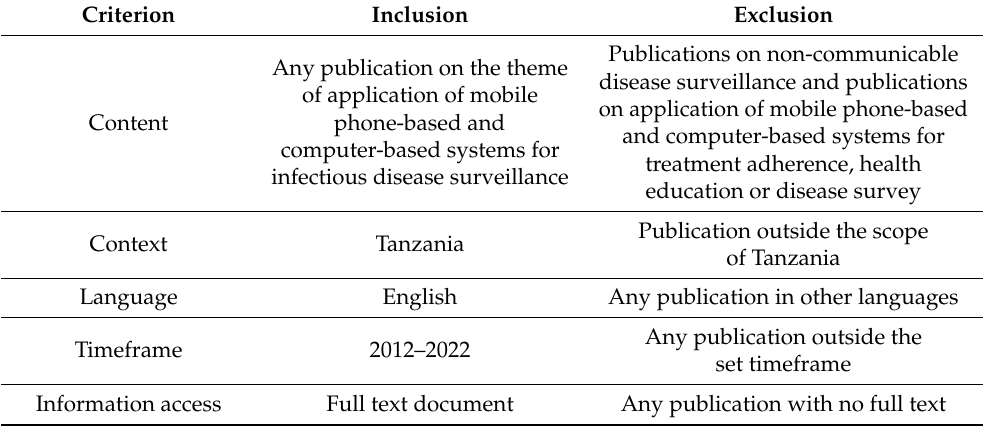
Table 1. Inclusion and exclusion